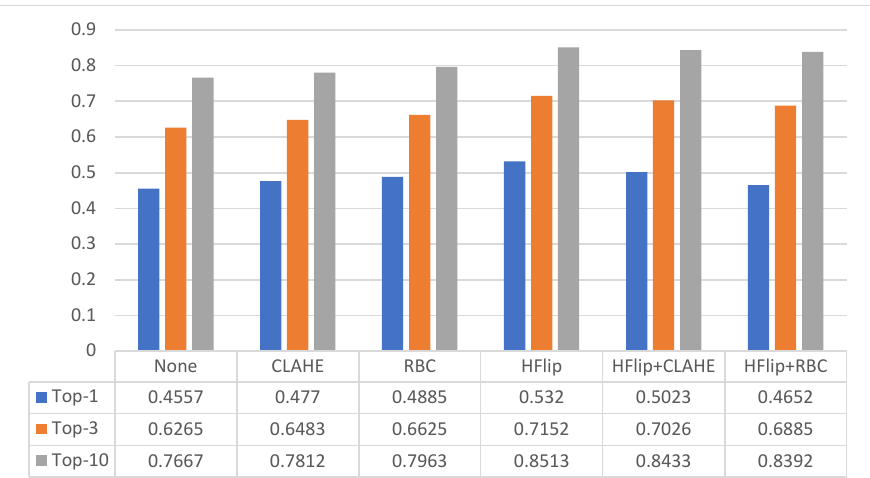
Figure 7. Effects of data augmentation